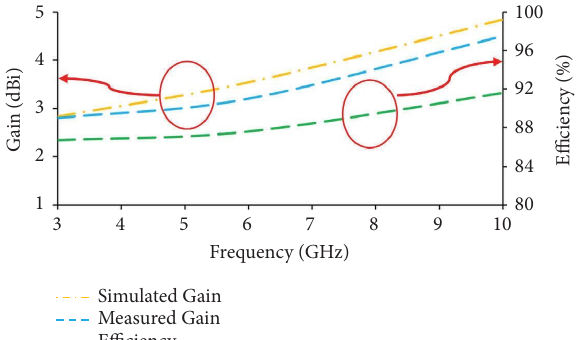
Figure 13: Gain and efciency plots of the antenna.